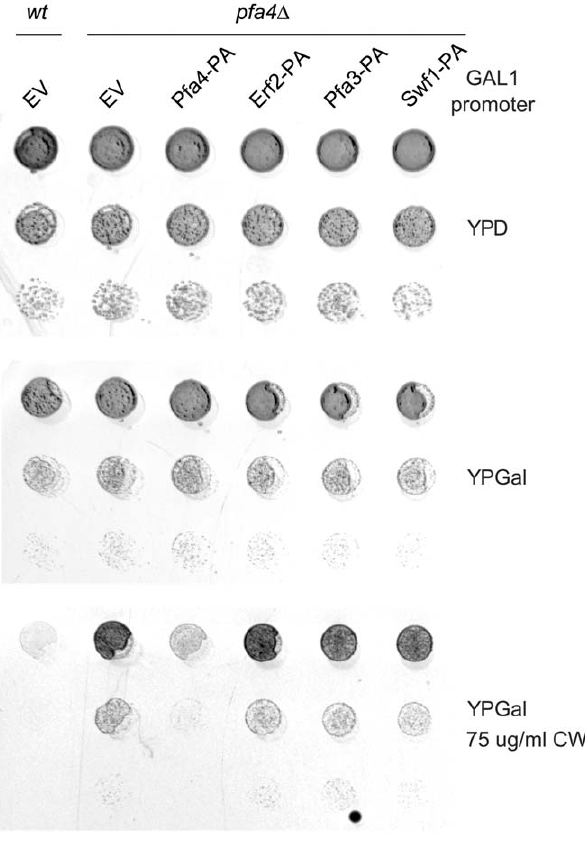
Figure 3. Pfa4 function cannot be carried out by other yeast PATs. Serial dilutions of a wt strain or a pfa4 D strain transformed with an empty vector (EV), or plasmids containing protein-A tagged Swf1, Erf2, Pfa3 or Pfa4 under the control of the GAL1 promoter. Transformants were grown in solid rich medium containing glucose (YPD, upper panel) or galactose (YPGal, medium panel) as carbon source, or in YPGal supplemented with 75 m g/mL Calcofluor White (YPGal CW, lower panel).